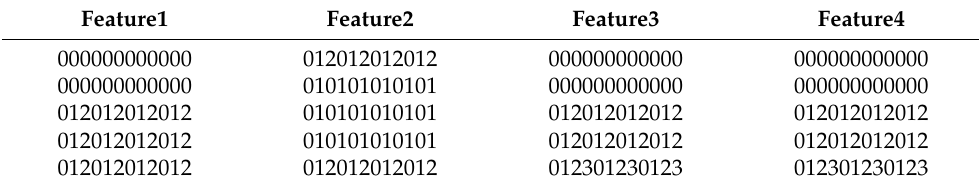
Table 4. Encoded data obtained after applying encode_df to the standardized data of Table 3.